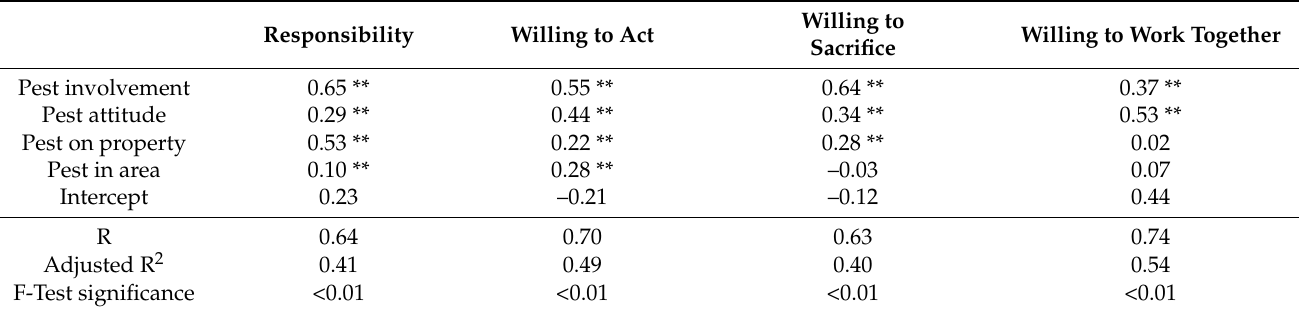
Table 9. Coefficient estimates for personal responsibility, willingness to act, willingness to sacrifice and willingness to work together.